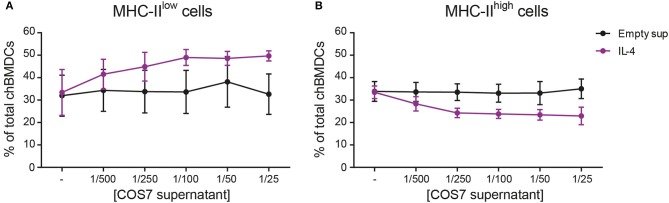
Addition of interleukin-4 (IL-4) to the culture medium during chicken bone marrow-derived dendritic cell (chBMDC) culture reduces the proportion of major histocompatibility complex class II (MHC-II)high cells. The effect of IL-4 on MHC-IIlow
(A) and MHC-IIhigh chBMDC (B) subsets was assessed by flow cytometry. Supernatant from a COS-7 cell culture transfected with recombinant IL-4 (purple) was used as a source of IL-4, and supernatant from COS-7 cells transfected with an empty vector was used as a control (black). The graphs show the percentages of both chBMDC subsets within total chBMDCs after culturing the cells in the presence of titrated concentrations of IL-4 or empty supernatant control. Both panels show the mean of four independent replicates; the error bars of all panels show the SEM.